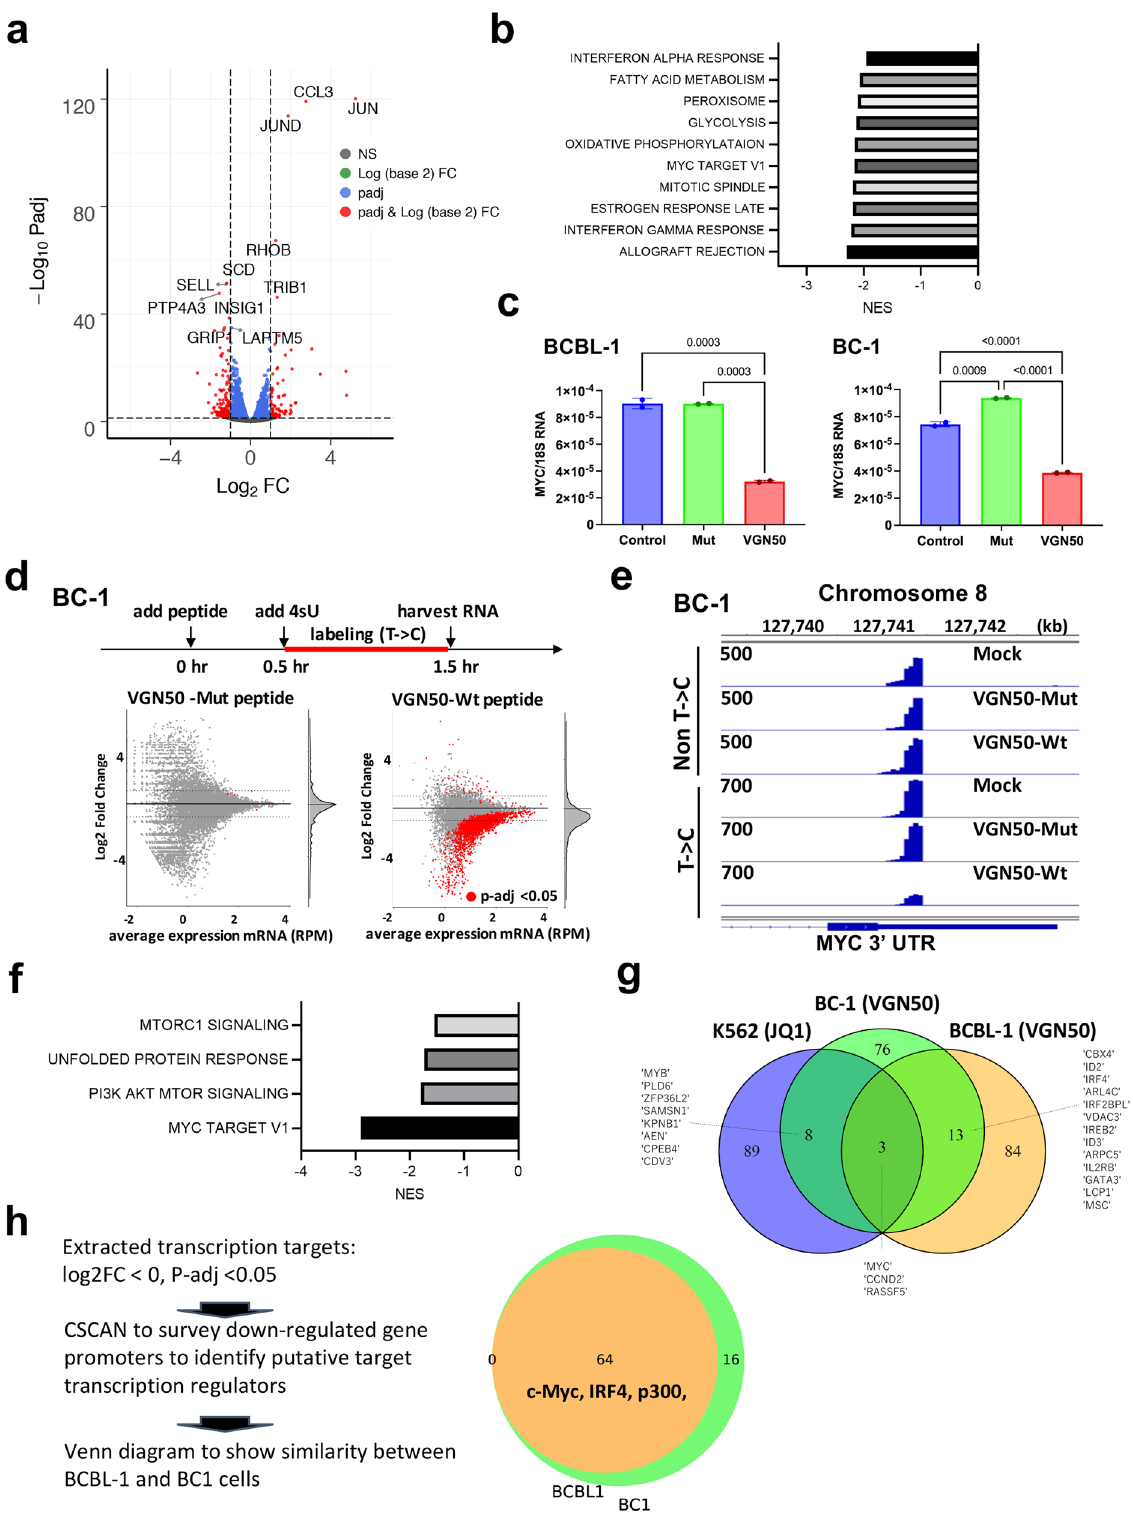
therapeutic potential of VGN50 by examining the ef fi cacy of cancer cell killing over toxicities to mice in a PEL xenograft model with BCBL-1 cells. Pilot studies determined that the peptide was well-tolerated in immunocompetent mice when administered as 10 mg/kg peptide via intraperitoneal (i.p.) injection with a 5-day- on 2-day-off schedule for 2 weeks, as shown by no notable changes in body weight, complete blood counts, and serum